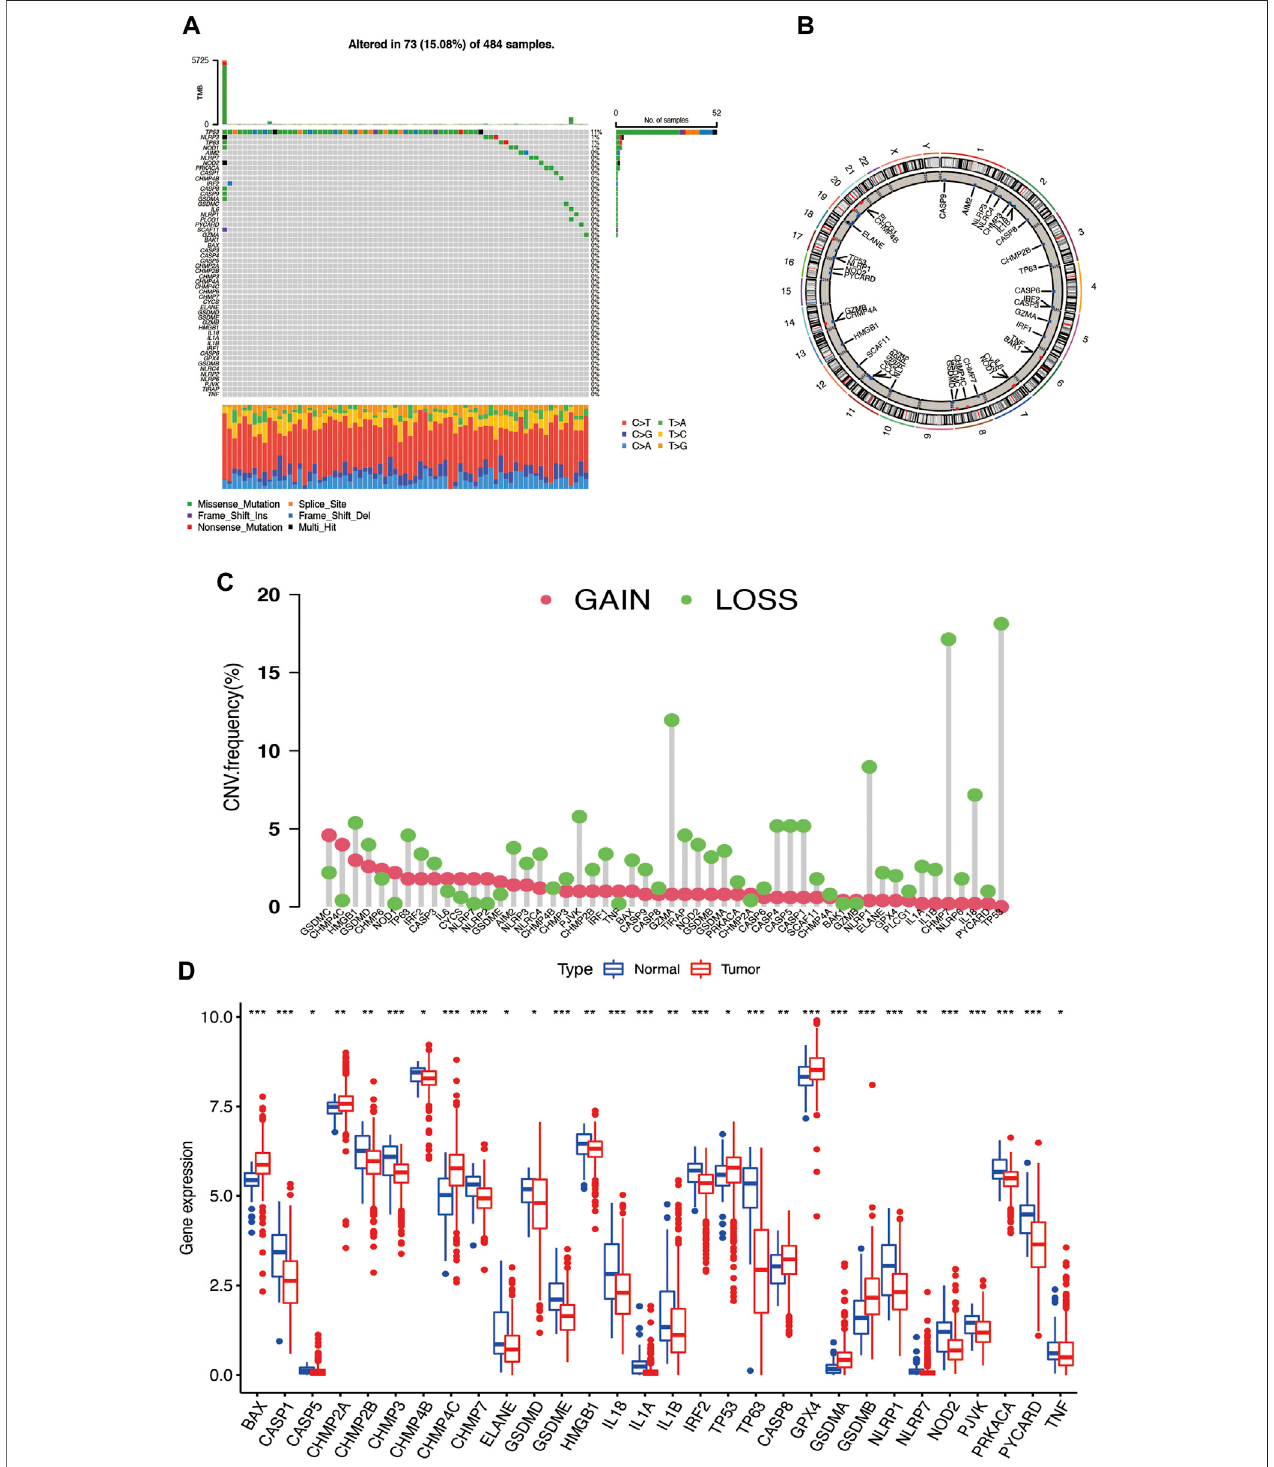
FIGURE 1 | (A) Somatic mutation of PRGs in prostate cancer. (B) Copy number variation of PRGs in prostate cancer somatic cells. (C) The localization of CNV in chromosomes. (D) The differential expression of PRGs in tumor and normal tissues.